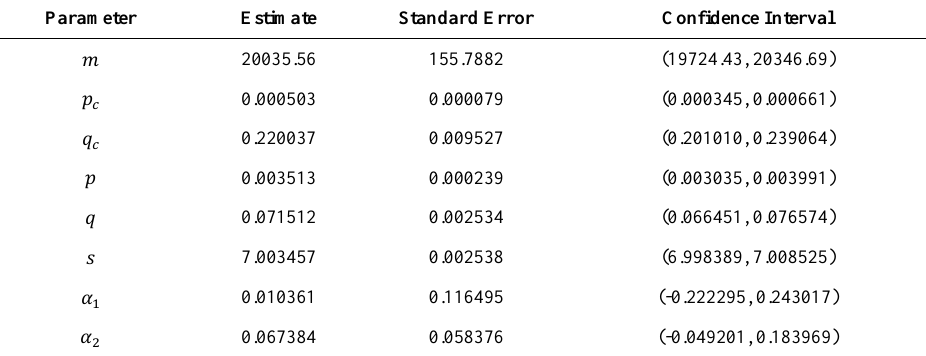
Table A5. Veneto. Estimates, asymptotic standard errors and 95% mCIs for the parameters of the DMPseas (9)+(10).